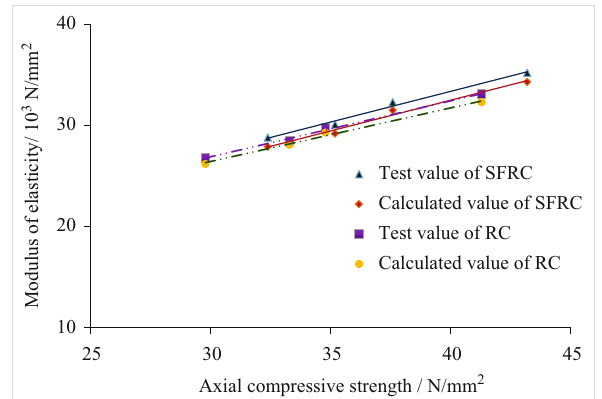
Figure 10: Relationship between elastic modulus and compressive strength of concrete.